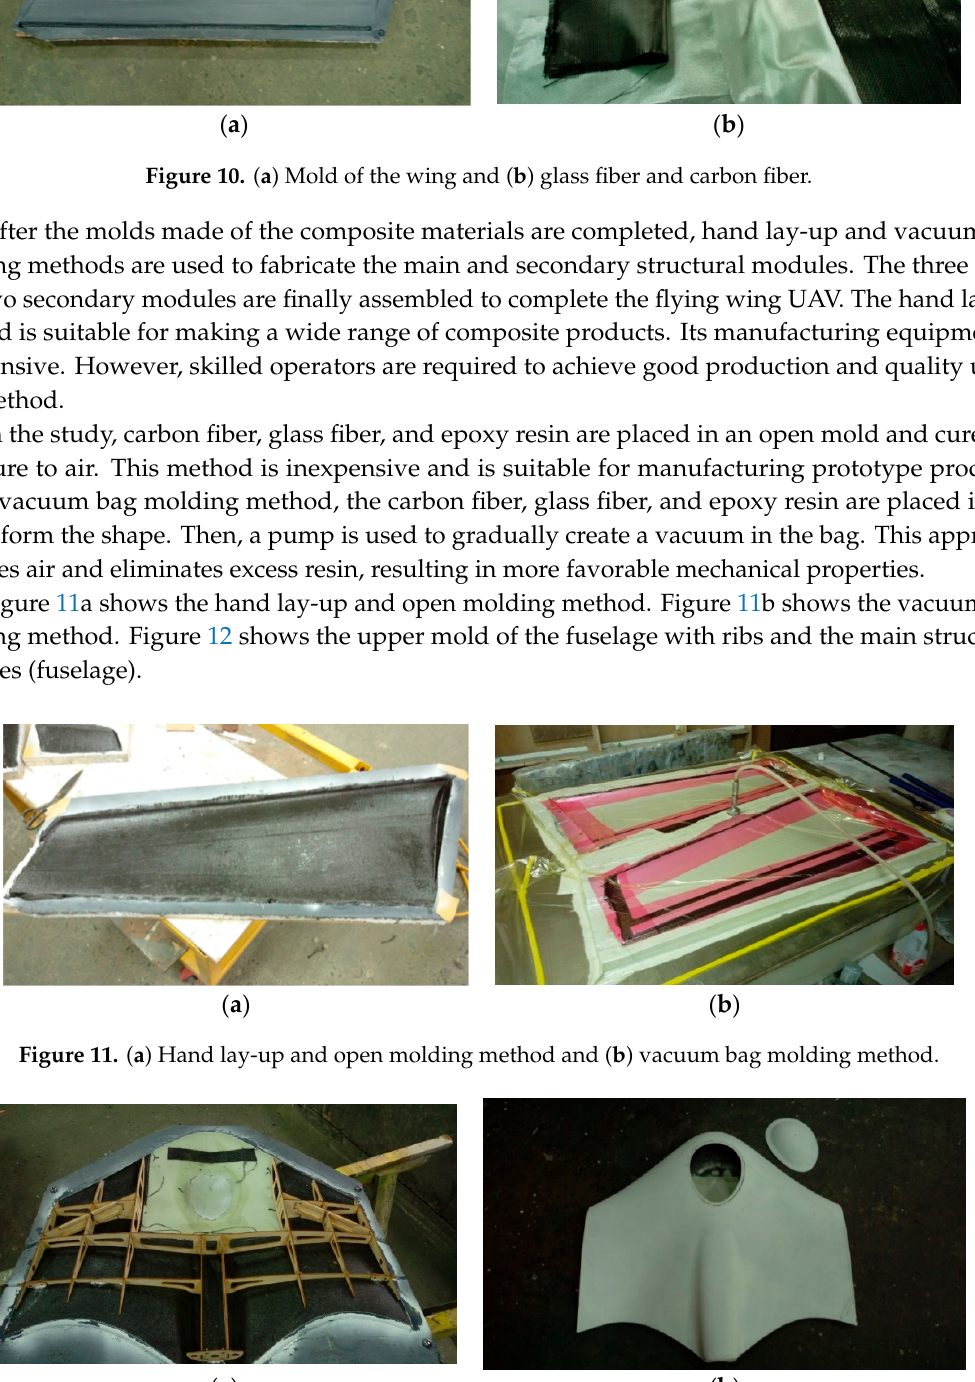
Figure 9. ( a ) Predesigned size of Styrofoam mold (fuselage) and ( b ) design size of mold consisting of Styrofoam, glass fiber, and epoxy resin (fuselage).